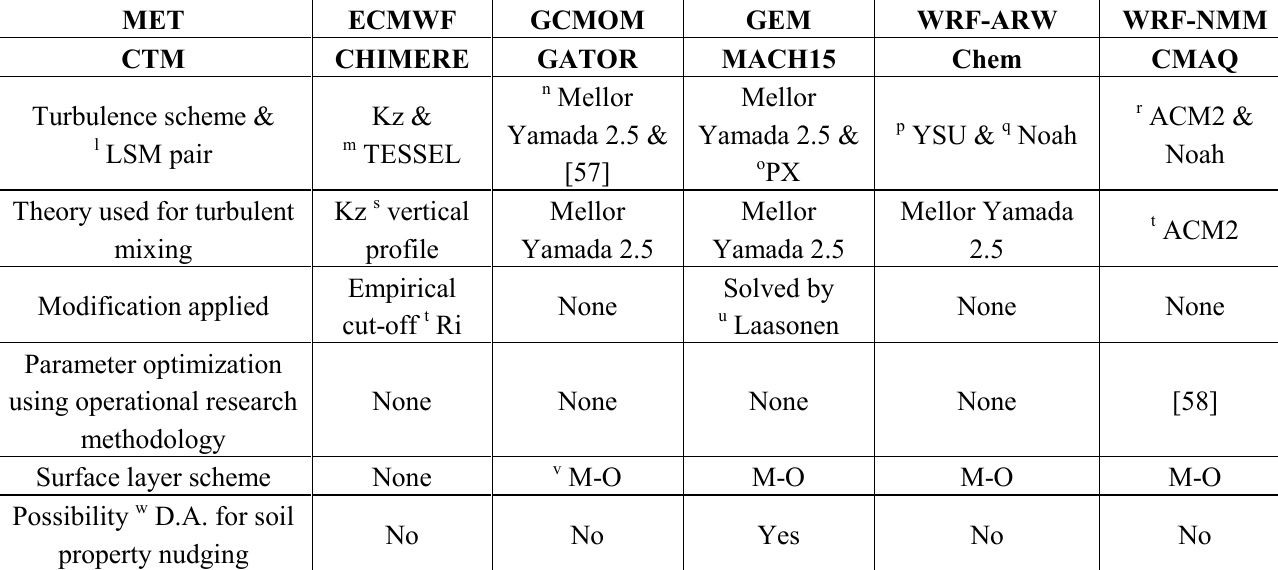
Table 2. Same as in Table 1, except that the conditions for turbulent mixing parameterization in the PBL are